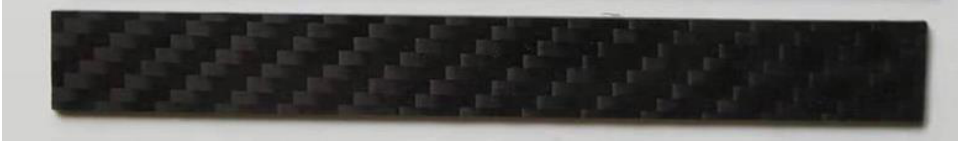
Figure 7. The sample after cutting based on ASTM D2344.